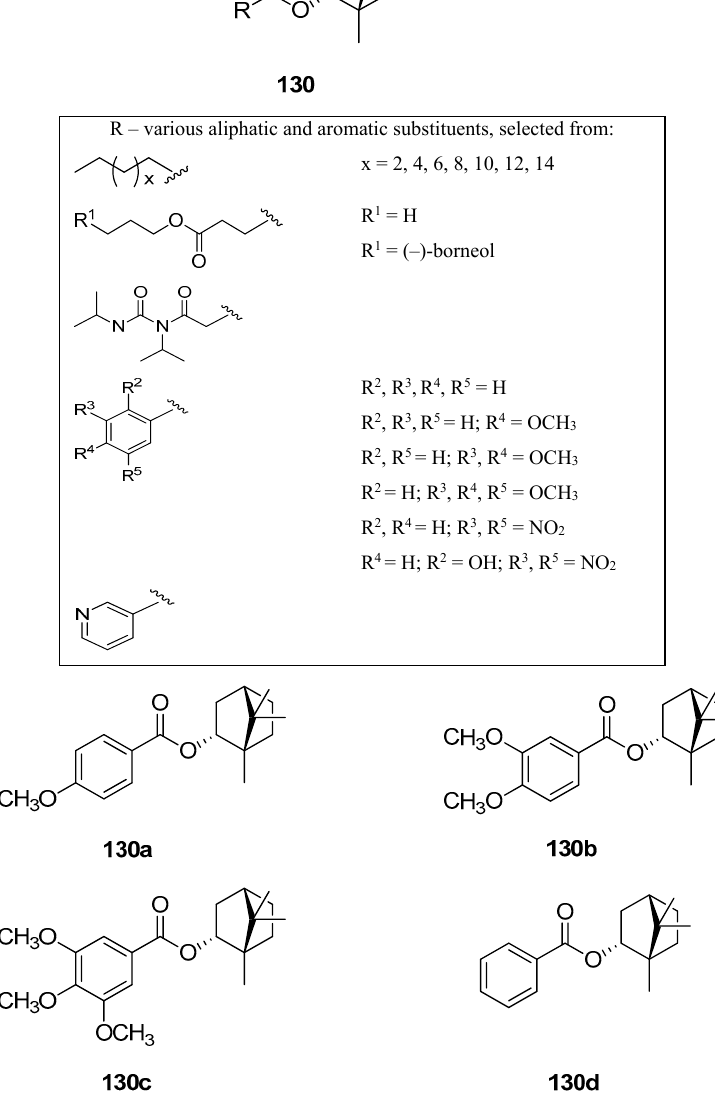
Figure 34. Aliphatic and aromatic esters of (–)-borneol derivatives were tested as antimicrobial agents [109] and as antiproliferative and antioedematogenic agents [108]. and as antiproliferative and antioedematogenic agents